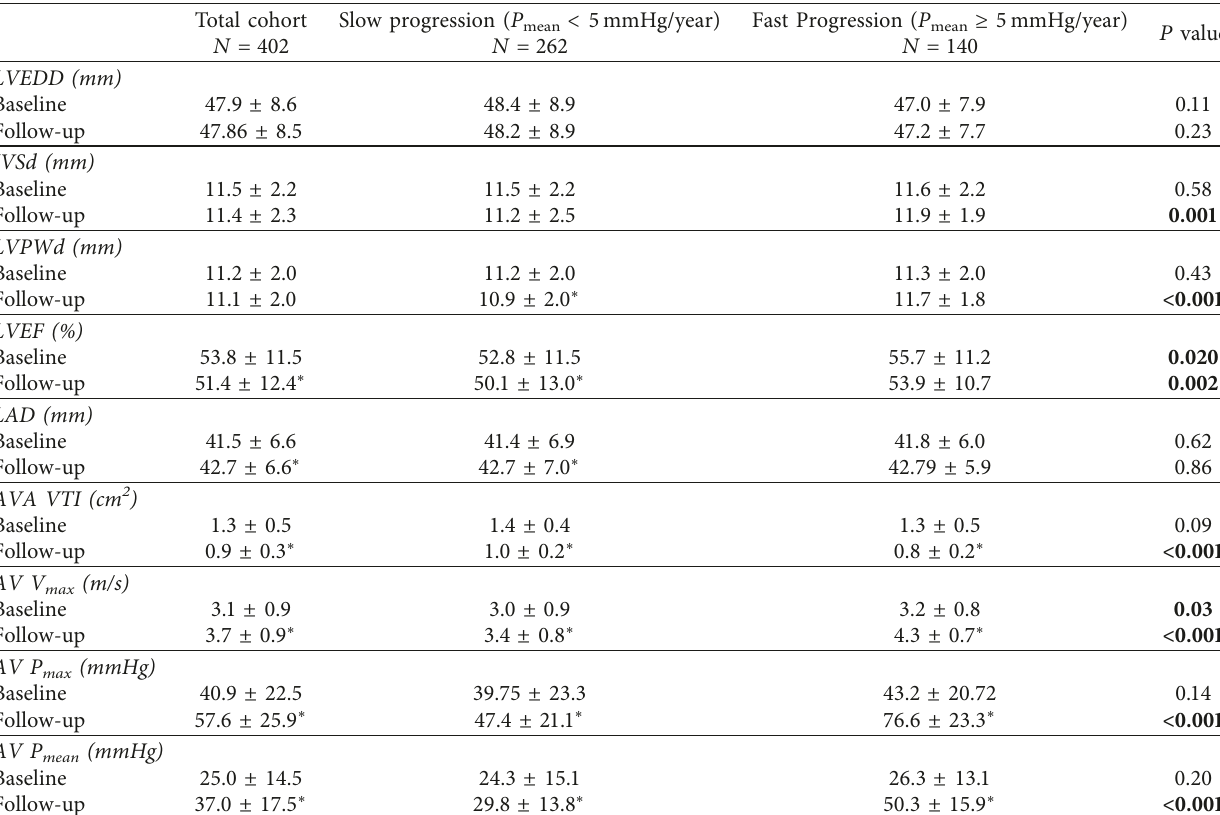
Table 4: Echocardiographic characteristics between baseline and follow-up.